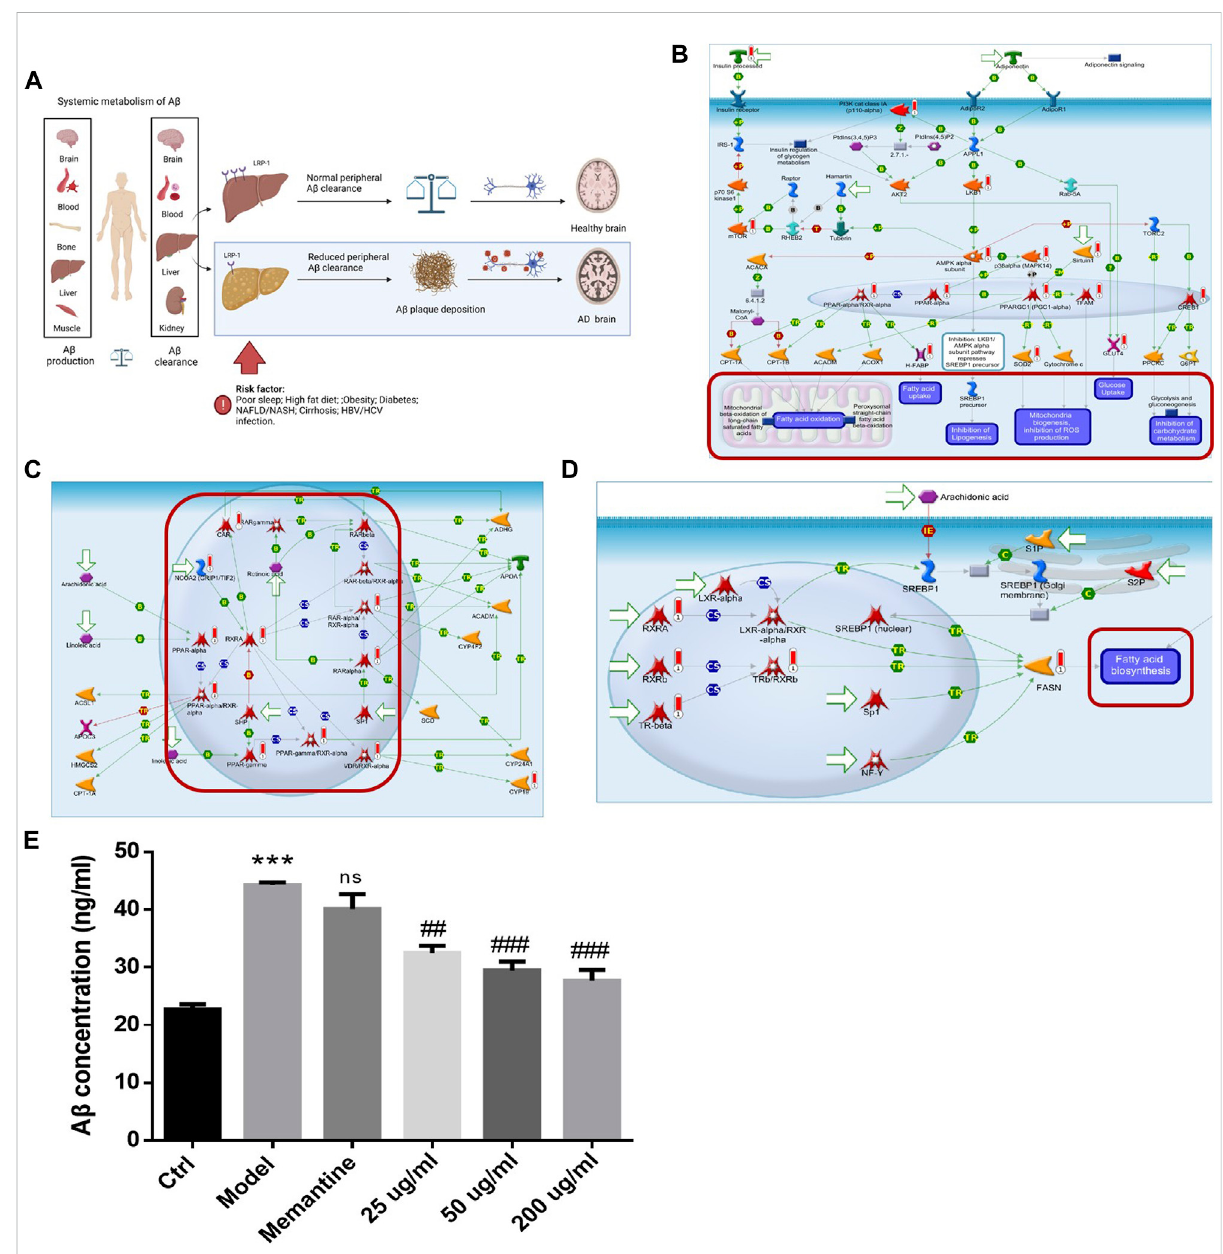
FIGURE 6 YXQNW promotes a β degradation by regulating the glucose and lipid metabolisms in AD treatment. (A) Summary of liver dysfunction in AD; (B) regulation ofthemetabolism_role ofAdiponectininregulationofmetabolism; (C) regulationoflipidmetabolism_RXR-dependentregulationoflipid metabolism via PPAR, RAR, and VDR; (D) regulation of lipid metabolism_regulation of fatty acid synthase activity in hepatocytes. (The red marker is the target of YXQNW); (E) YXQNW may promote A β degradation in hepatic stellate cells. Rat hepatic stellate cell HST-T6 was incubated with different concentrations of YXQNW or negative control drug Memantine (100 μ M). After 48 h of incubation, add A β 1-42 (1 μ M) into the cell except blank control group for 1 h of ingestion. Cellular A β accumulation was detected by an A β ELISA kit. *** p < 0.001 is compared with the Ctrl group; ## p < 0.01, ### p < 0.001 is compared with the Model